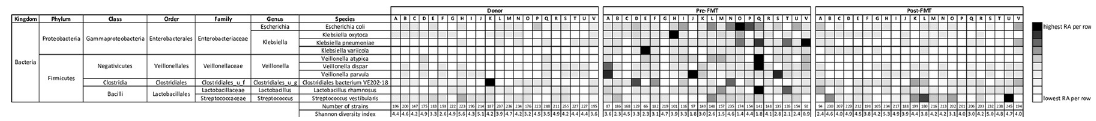
Fig 5. Heat map depicting the top 10 bacterial species sorted by highest relative abundance in the pre-FMT RCDI patient group. Shannon diversity index and number of bacterial strains are depicted at the bottom of heat map. A marked increase in RA of certain pathobionts was observed in the pre-FMT state as compared to donors and post-FMT